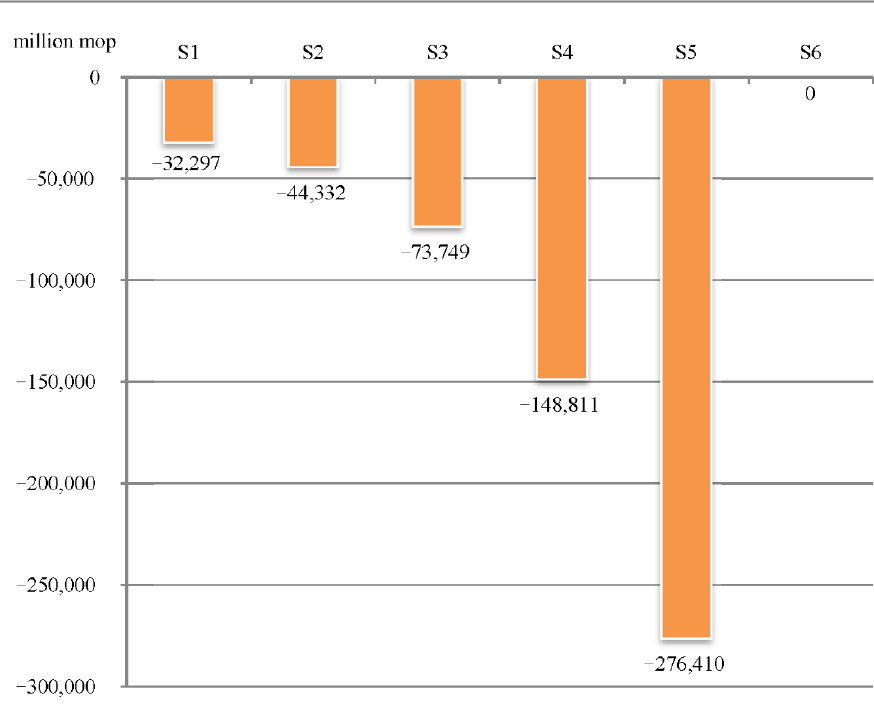
Figure 6. The relationship between 2017 – 2019 gross gaming revenue and the number of tourists in and out of Macao.